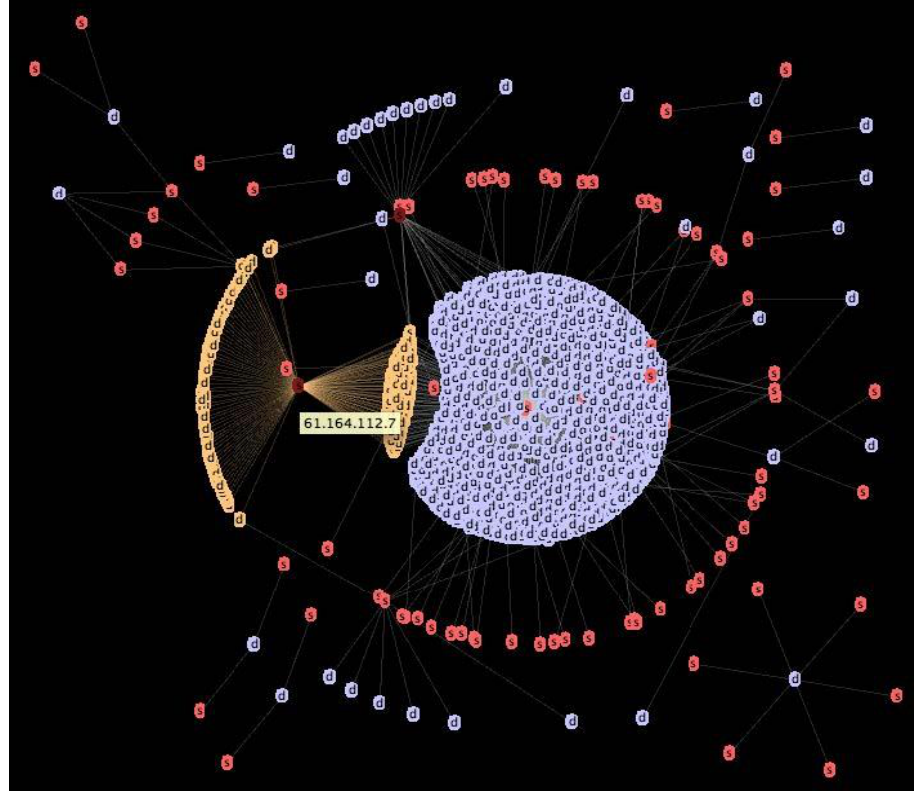
Fig. 1. Graphical visualization displaying communication flows between destination hosts (blue) and source